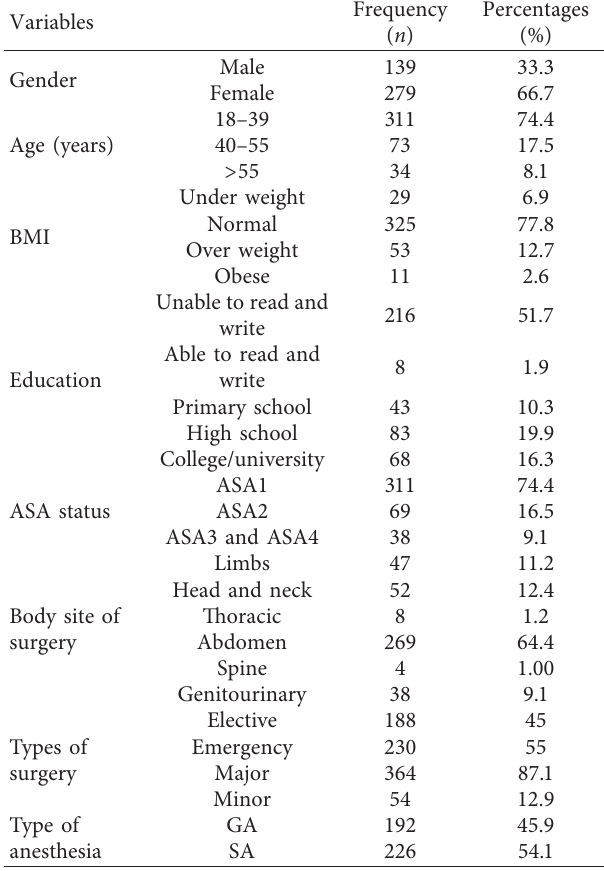
Table 1: Sociodemographic and clinical characteristics of patients underwent surgery under anesthesia at the University of Gondar comprehensive specialized hospital, northwest Ethiopia, 2018 ( N �